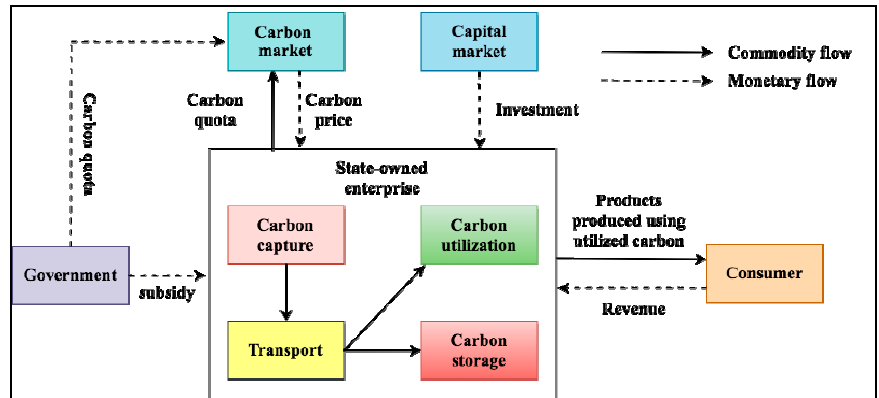
Figure 4. Vertically-integrated CCUS business model.